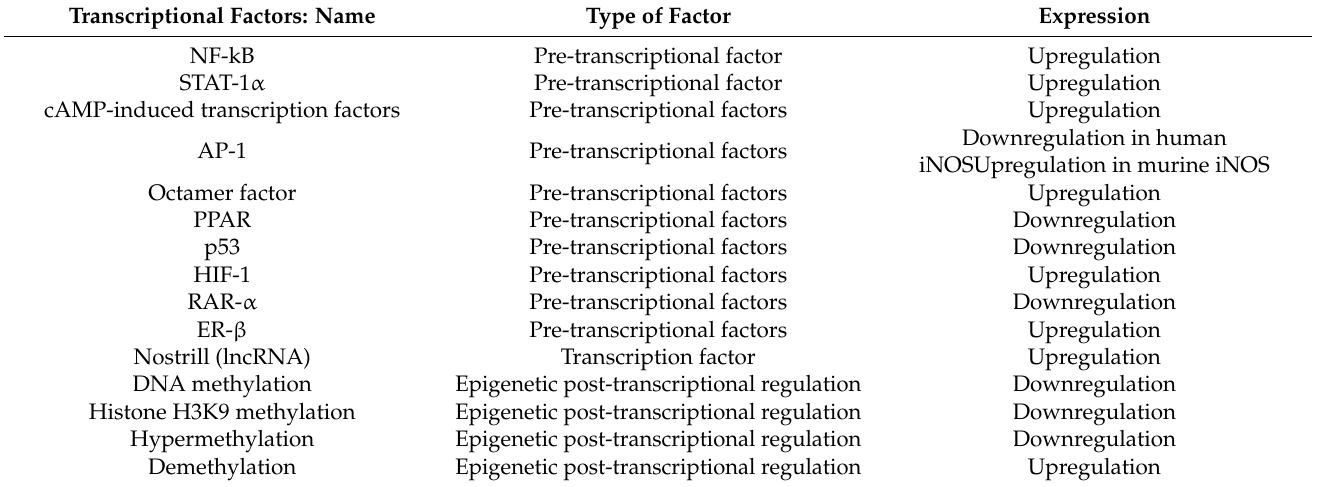
Table 1. Regulation of